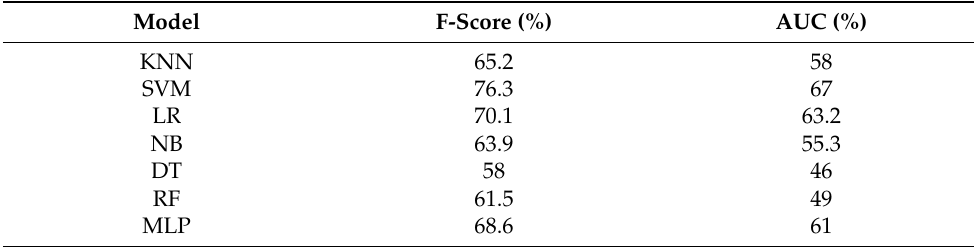
Table 9. Algorithmic performance for ‘Twitter with VADER’ data set.